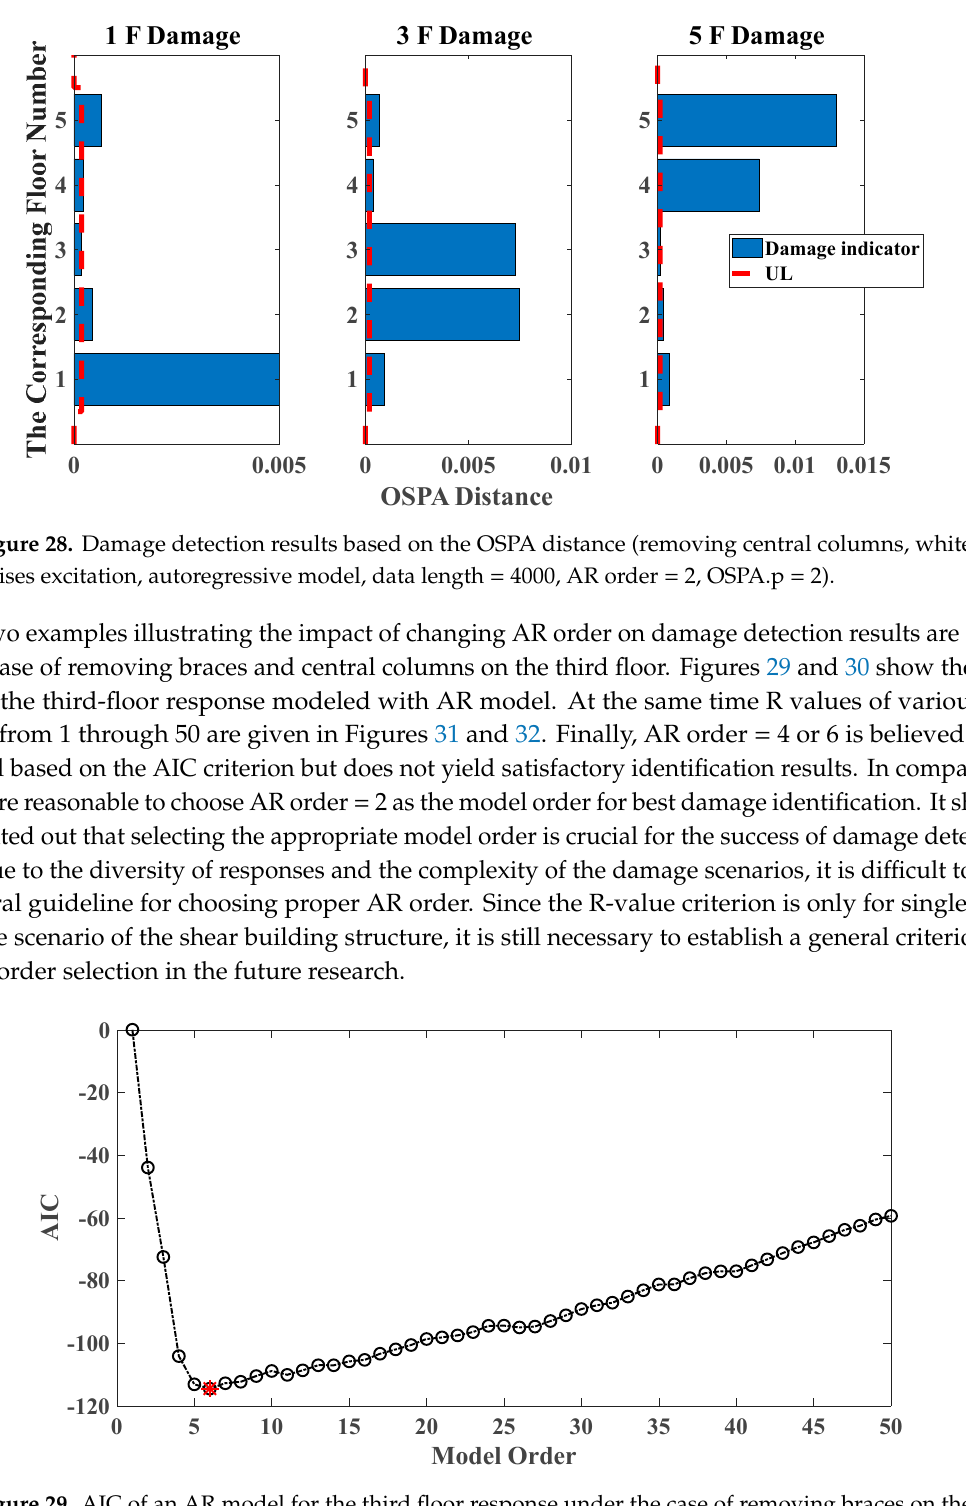
Figure 27. Damage detection results based on the OSPA distance (removing braces, white noises excitation, autoregressive model, data length = 4000, AR order = 2, OSPA.p = 2).